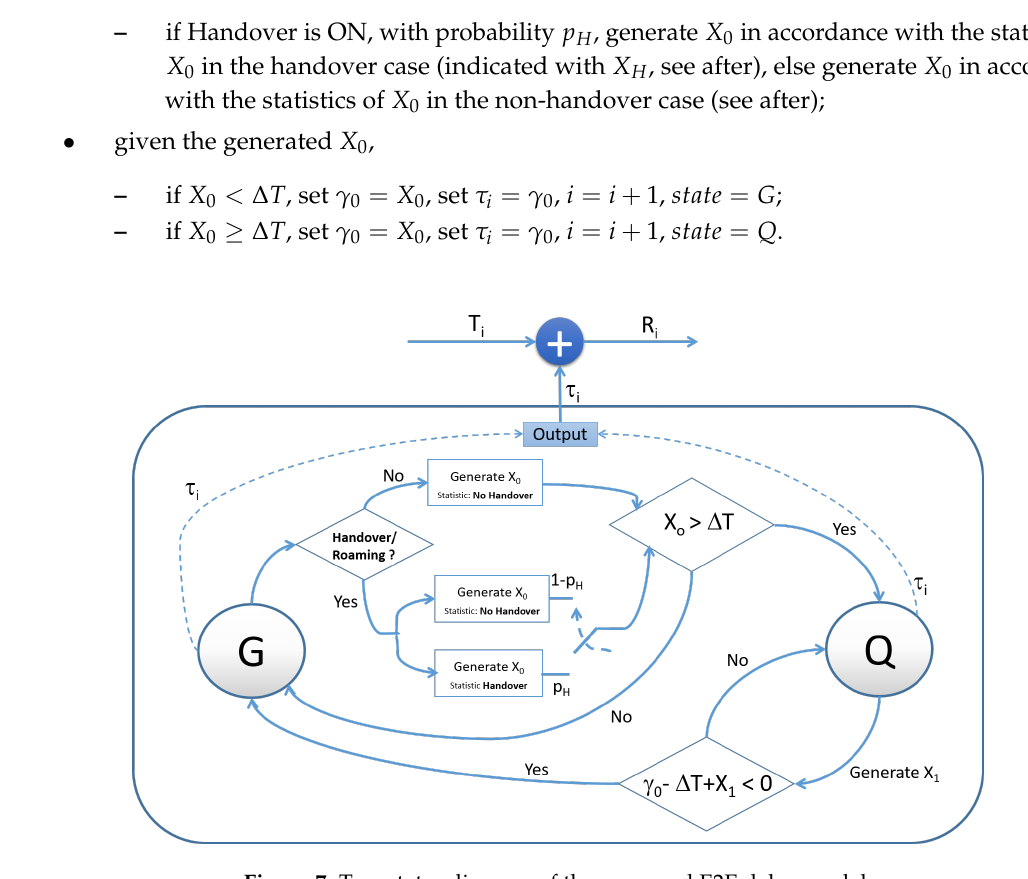
Figure 7. Two states diagram of the proposed E2E delay